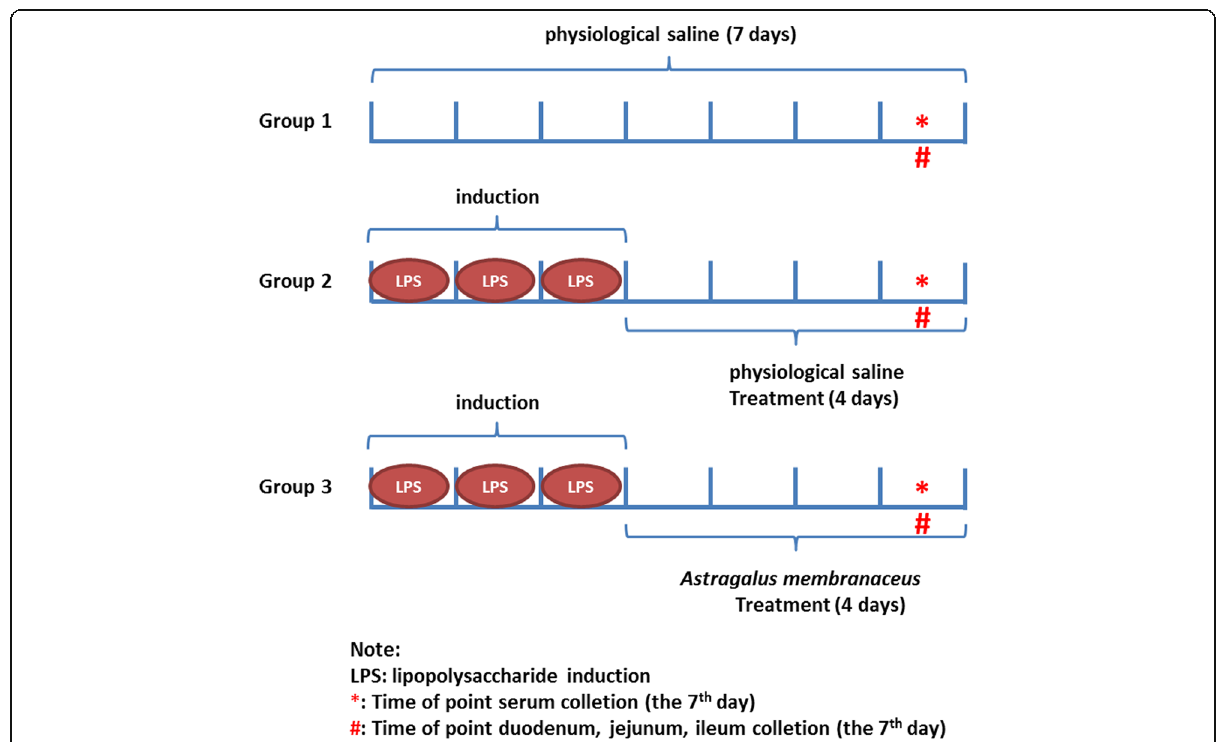
Fig. 1 Experimental design and sampling schedule